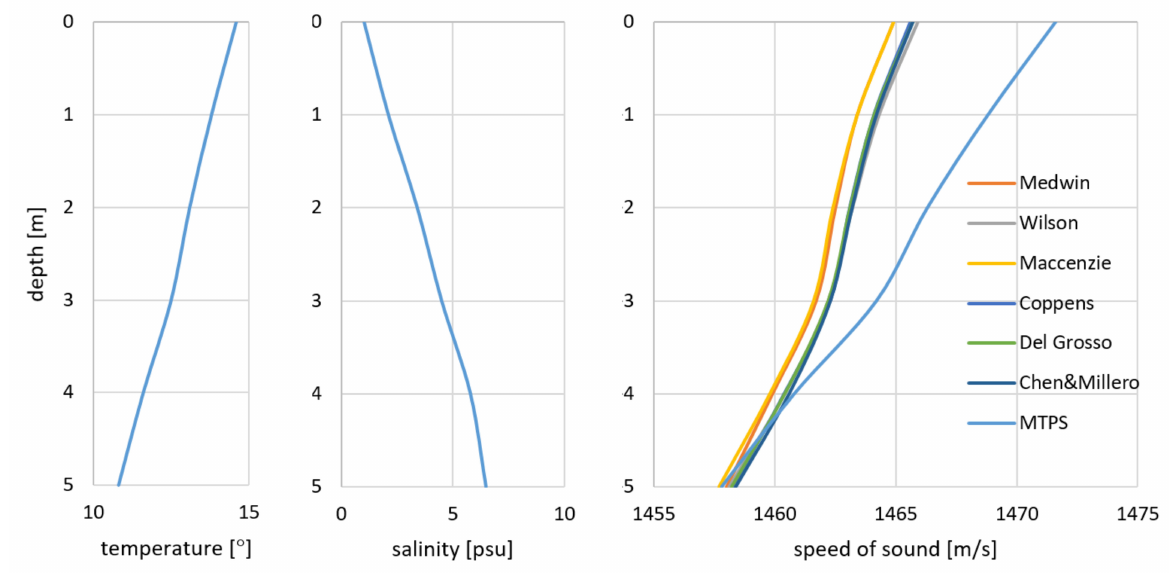
Figure 6. Temperature, salinity and sound speed in water profiles in the Motława River. Table 6. Depth measurement error (cm) for selected formulas according to MTPS (S = 6 psu) in the